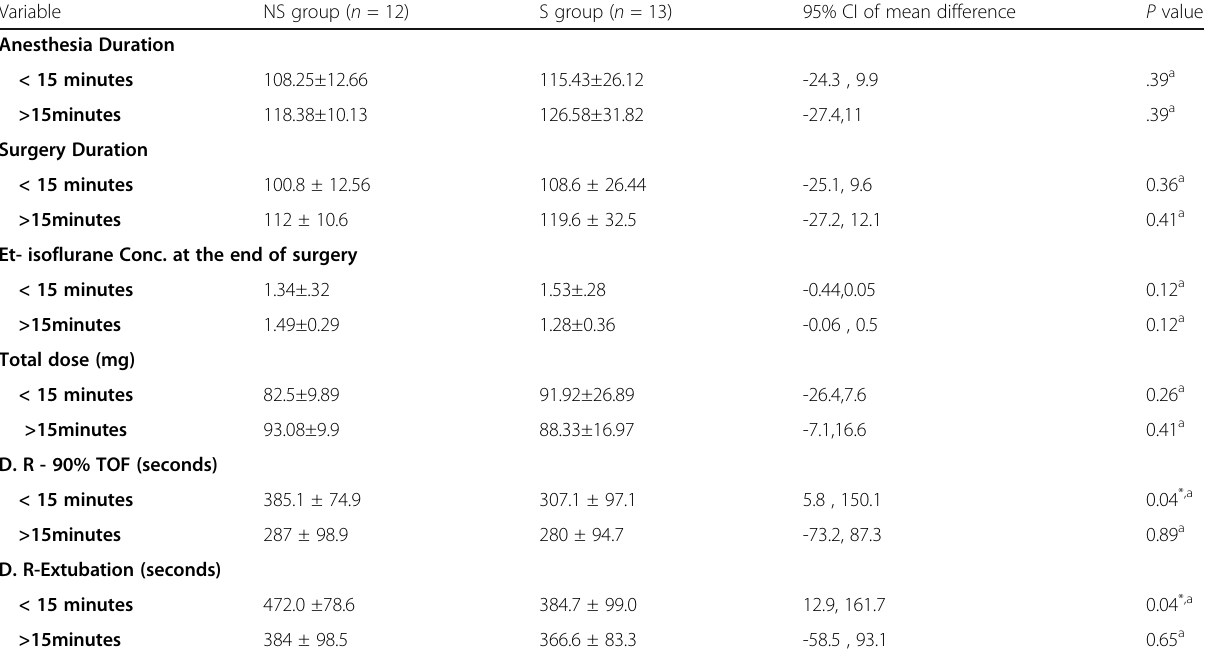
Table 4 Muscle relaxant recovery profile in both groups for patients who received reversal within less and more than 15 minutes after the last dose of rocuronium Variable NS group ( n = 12) S group ( n =